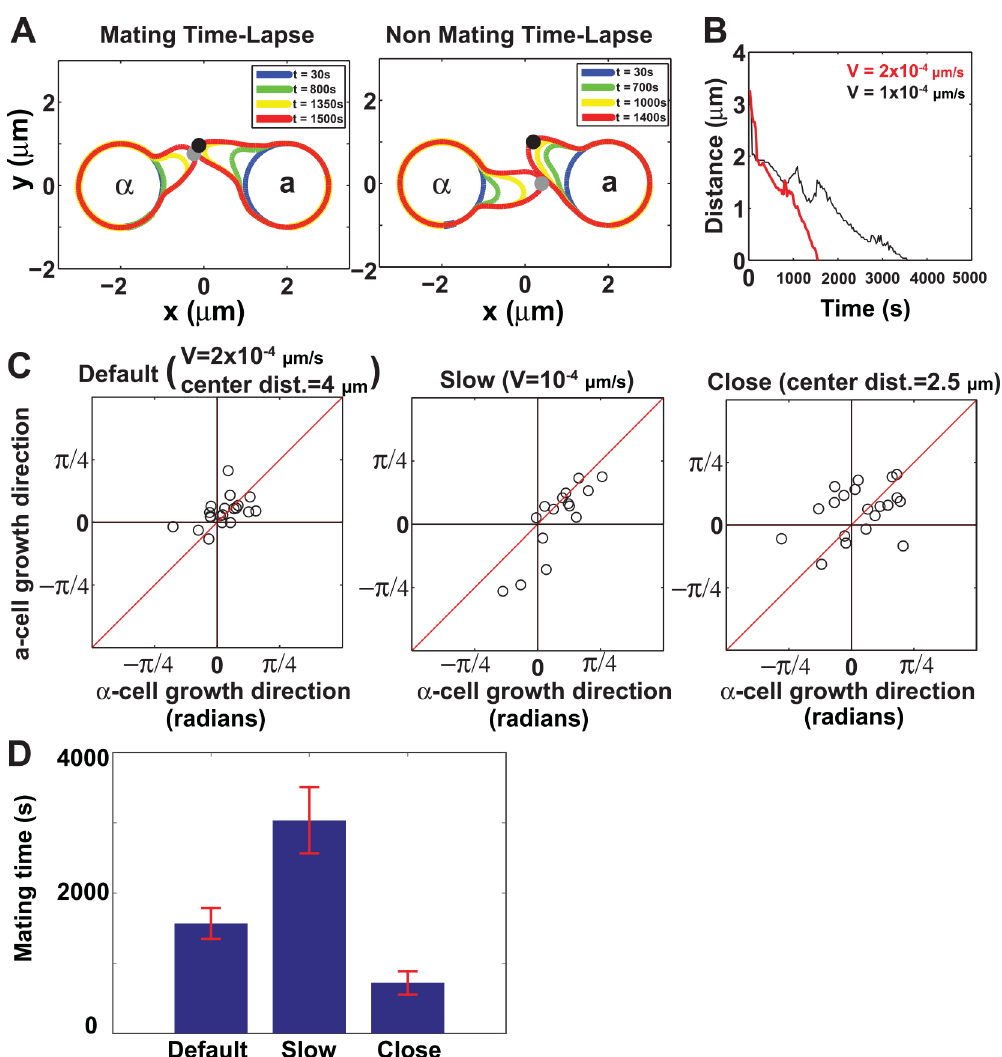
Fig 3. Computer simulations of mating efficiency. (A) Schematic of determining mating efficiency. In the simulation on the left, the tips marked by gray and black dots (polarisomes) of the two projections fall within a distance threshold (see Methods ) so that the mating is considered successful. In the simulation on the right, the tips do not pass close enough to one another by the end of the simulation, and so the mating is deemed unsuccessful. (B) Faster and slower boundary velocities yielded similar mating trajectories. We ran simulations at two different boundary velocities ( V amp = 0.0001 and V amp = 0.0002 μ m/s). A plot of the distance between polarisomes of mating partners as a function of time is shown for a sample simulation. The plots are similar except the slower velocity took approximately twice as long to mate. (C) Direction plots for different boundary velocities and shorter cell-to-cell distance. In this plot each data circle represents one mating simulation. The average direction of each projection is plotted on the x -axis for the α -cell, and y -axis for the a-cell. The projections are toward one another when the data point lies along the diagonal line (i.e. top right and bottom left quadrants). We show the direction plots for the default simulation parameters (V = 0.0002 μ m/s, left), slow boundary simulation (V = 0.0001 μ m/s, middle), and close-cell positions (cell-to-cell distance = 2.5 μ m instead of 4 μ m, right). The mating efficiencies were similar for all three simulations. (D) Average mating time of successful matings under different simulation conditions same as in (C). Each bar represents the average time ( ± standard deviation) for successful mating. We performed 20 simulations for each condition, and the numbers of successful matings for default, slow and close parameters are 15, 17 and 16